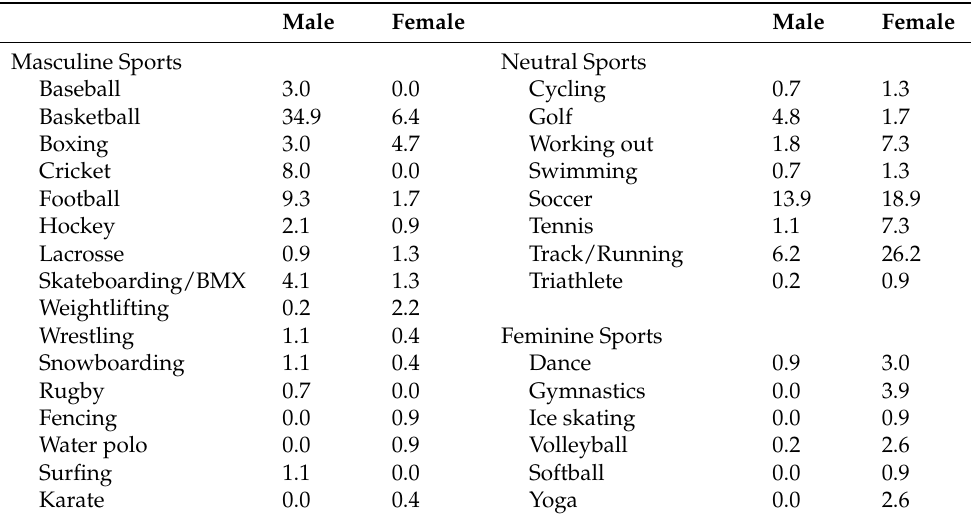
Table 2. Percentage of athletes presented in each sport in Nike commercials, 2010–2019. Male Female Male